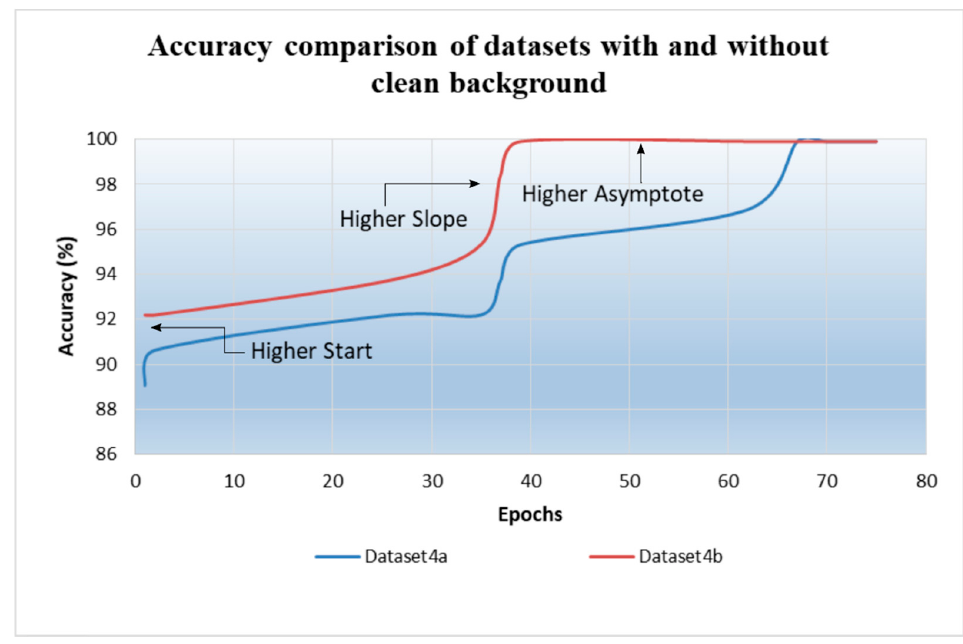
Figure 12. Comparing the accuracy of fine-tuned MobileNet on image sets (cabbage leaves) with and without clean background. without clean